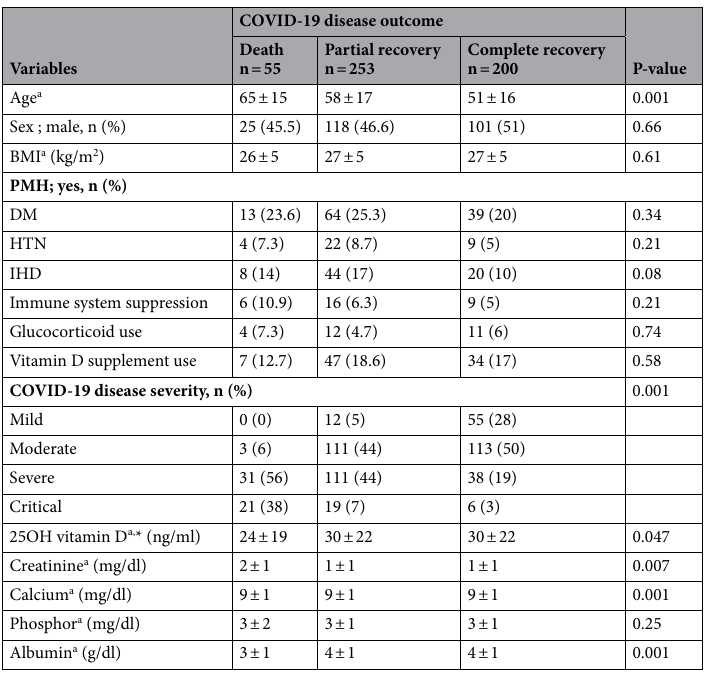
Table 2. Demographic and medical characteristics of 508 cases of COVID-19 disease categorized by outcome. DM diabetes mellitus, HTN hypertension, IHD ischemic heart disease, BMI body mass index. a Mean ± SD. *The P-value has been calculated after recategorized disease outcome to recovery and death